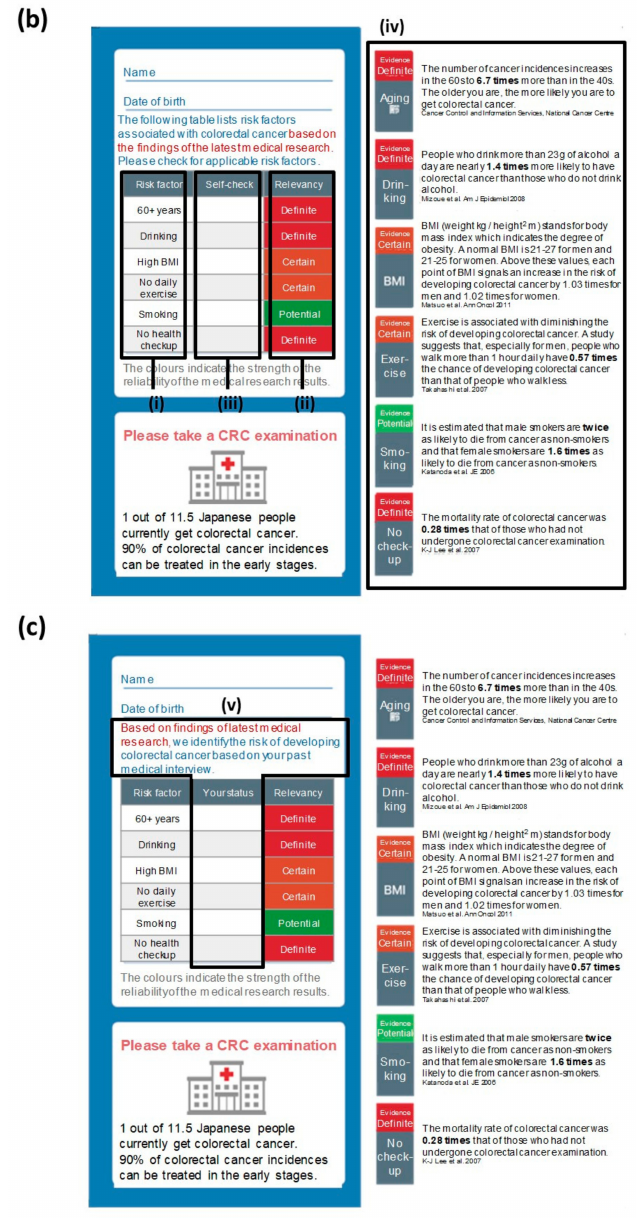
Figure 2. The recommendation materials used in this case. ( a ) The common material of the first round of recommendations contained each piece of the ‘EAST (easy, attractive, society, and timely)’ framework for nudge: (i) It emphasized that CRC screening can be self-completed at home (easy); (ii) it mentioned that the subsidy from the city would reduce the actual cost burden by JPY 3800 (84.5%; attractive); (iii) it was clearly indicated that it was a notification from the city for a public health purpose (society); (iv) it set a fixed period for CRC screening with a defined deadline (timely). ( b ) The non-customized material in the second round of recommendations exhibited a check sheet with (i) the major six risk factors of CRC, (ii) the relevancy of each factor to the incidence colored in red, orange and green in accordance to the risk level, (iii) the relevancy of the recipient’s condition to each of these factors for self-checking, and (iv) epidemiological details in each of these factors. ( c ) The customized material in the second round of recommendations used an identical format to the one in ( c ) except (v) the relevancy of the recipient’s condition that had already been filled in by the sender based on a precedent medical consultation. Note: These images or descriptions were translated into English by the authors. Supplementary figure provides the original version in Japanese. Note: These figures were translated by the authors from the original materials (Supplementary Figure